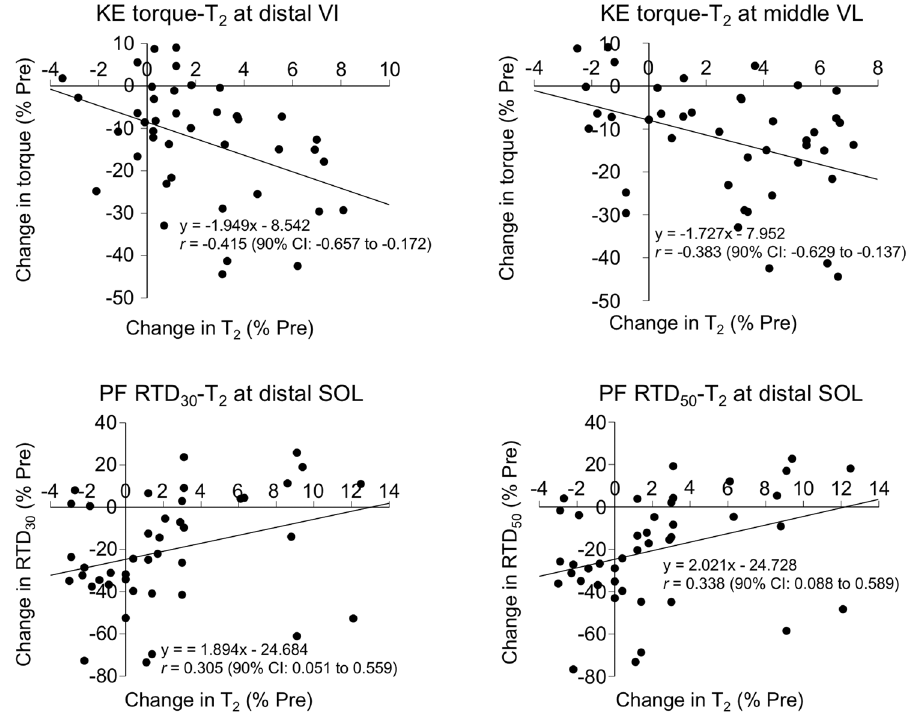
Figure 3. Relationships between changes in maximal torque of the KEs and T 2 at the distal VI (top left) and at the middle VL (top right), between changes in RTD 30 of the PFs and T 2 at the distal SOL (bottom left), and between changes in RTD 50 of the PFs and T 2 at the distal SOL (bottom right). KEs: knee extensors, PFs: plantar flexors, RTD 30,50 : rate of torque development in the time intervals of 0–30 and 0–50 ms, respectively, from contraction onset. Each graph has 42 plots (14 participants × 3 time points